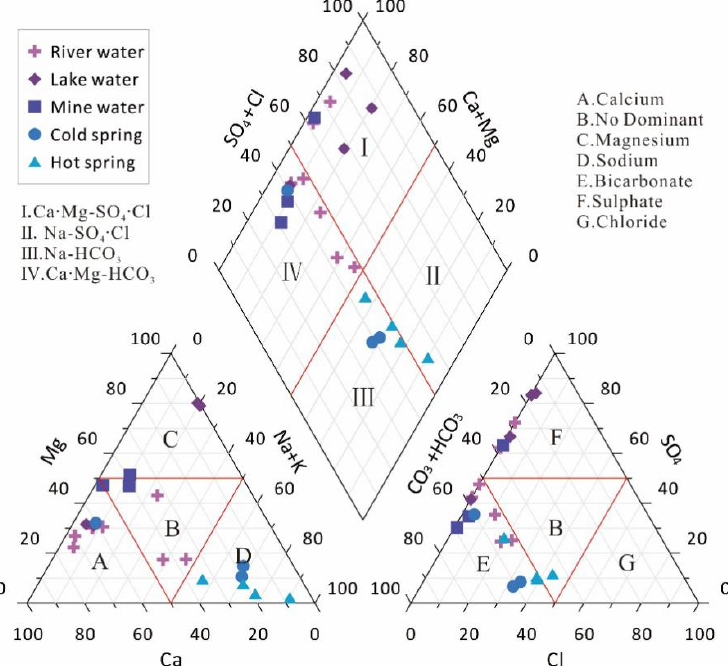
Figure 4. Piper diagram of river water, lake water, spring water and mine water.